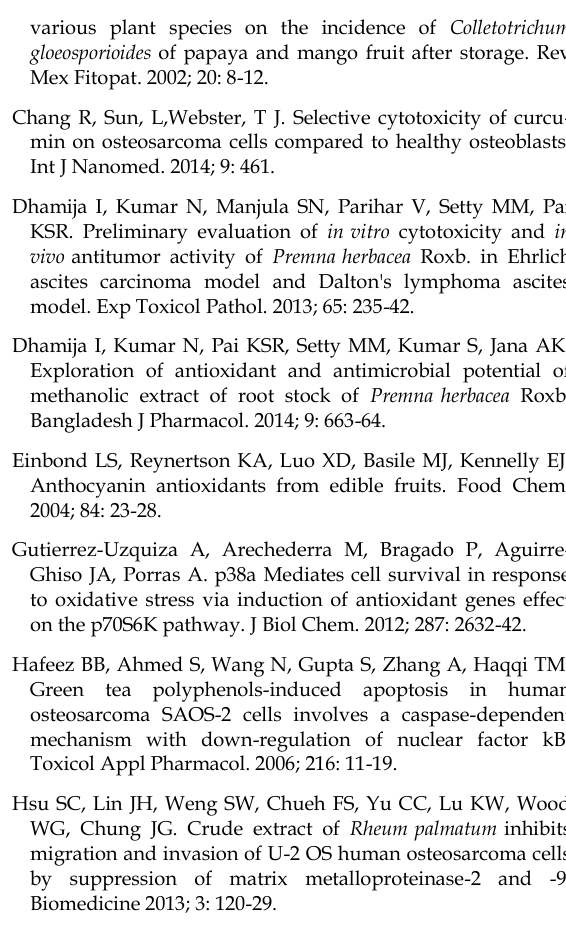
Figure 6: Effect of extract of different GAE concentrations on apoptotic cells in terms of caspase specific activity in cells. Results are represented as the mean of caspase specific activity (µmol/min/mg) with error bars representing SD from three repeats. Positive control represented the treatment of the cells with 10 µg/mL vincristine. *represents significant difference at p<0.05 from the un- treated control and #represents the non significance i.e. equivalence in comparison to standard (vincristine 10 µg/mL) positive control while ##represents the significantly higher caspase specific activity than that from standard or positive